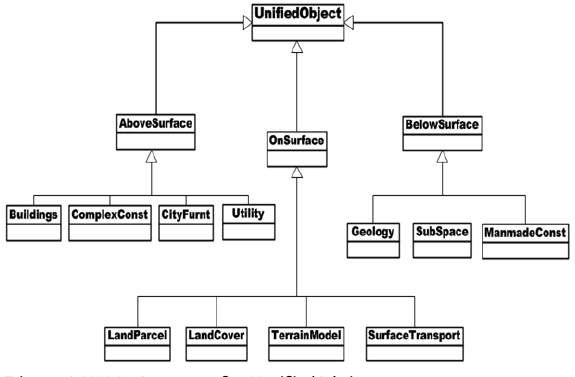
Figure 3 UML Concept for